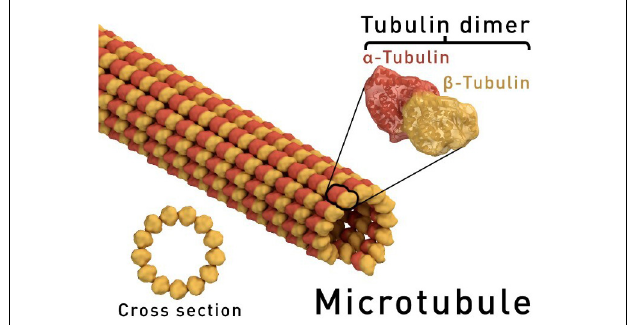
FIGURE 2 | Simulative structure of a microtubule. The ring shape depicts a microtubule in cross-section, showing the 13 protofilaments surrounding a hollow centre (https://goo.gl/images/BKJ9m3, under the Creative Commons Attribution-Share Alike 4.0 International